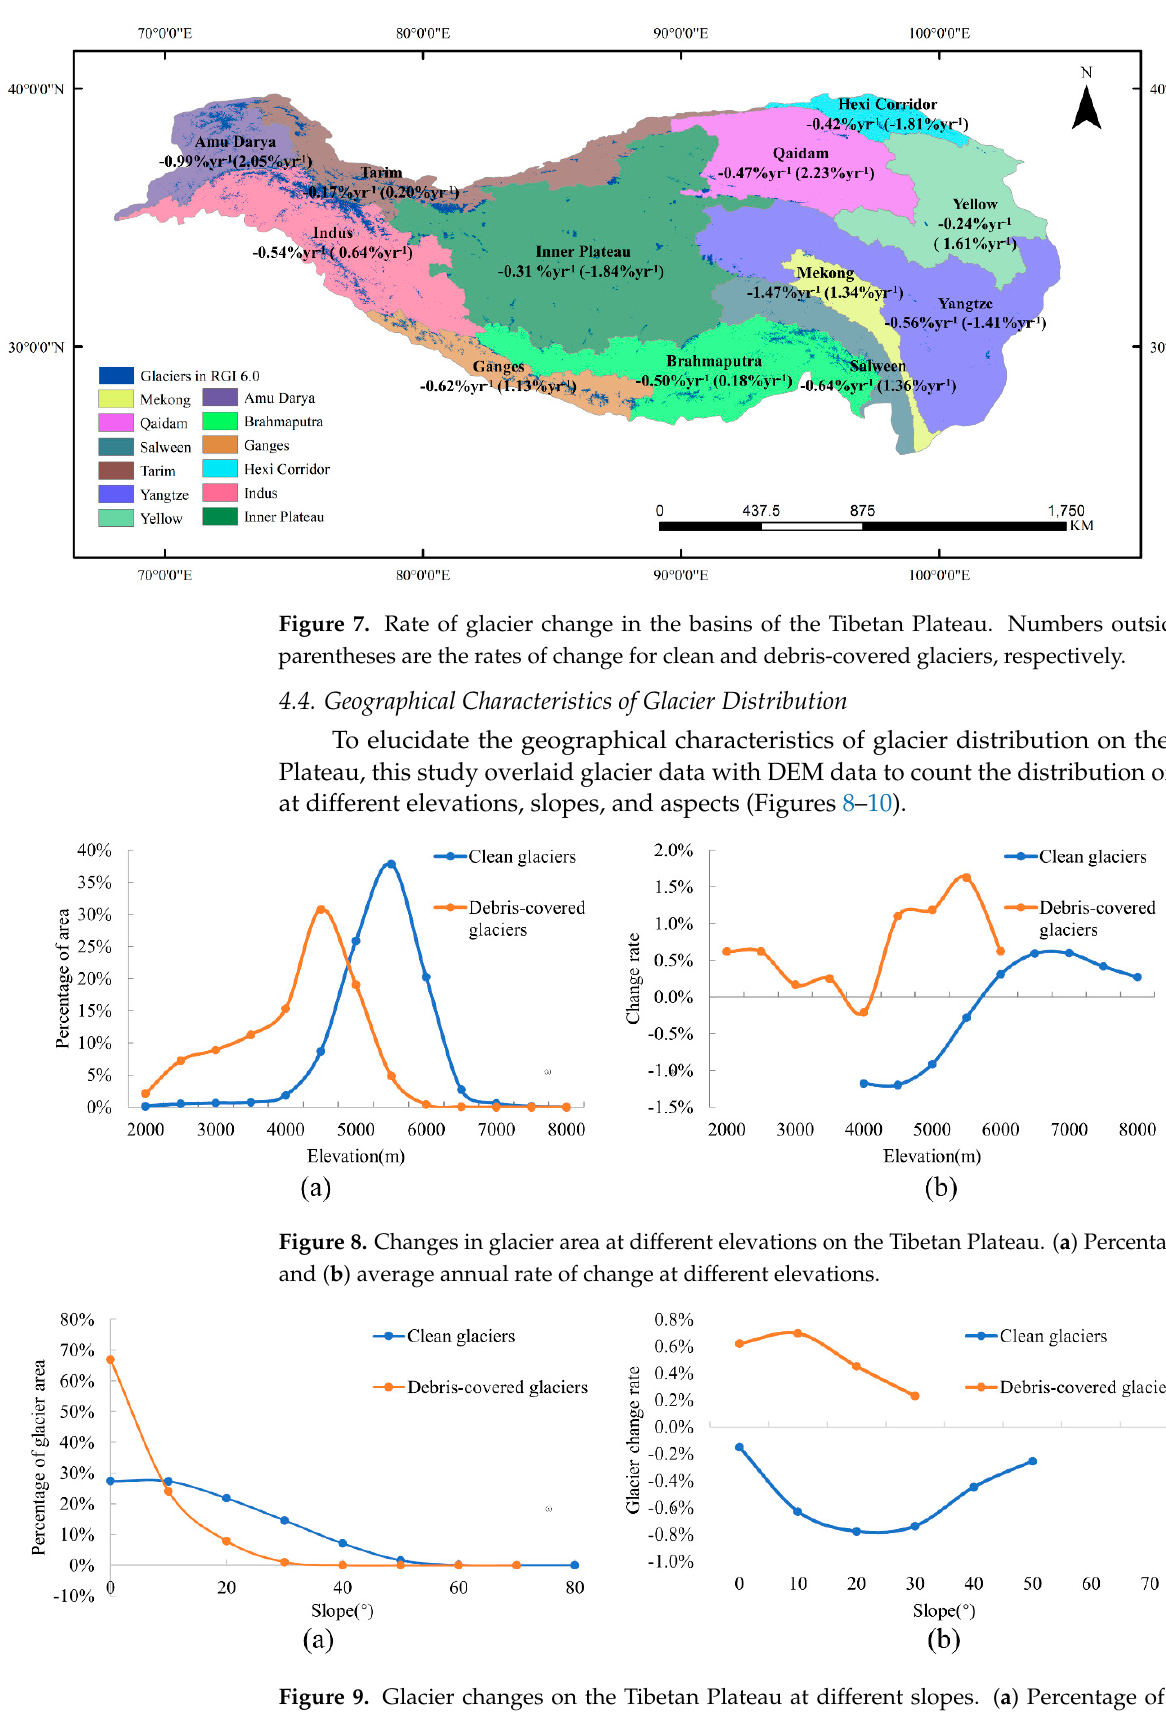
Figure 9. Glacier changes on the Tibetan Plateau at different slopes. ( a ) Percentage of area and ( b ) average annual rate of change at different elevations. 4.4.3. Glacier Distribution in Different Aspects The clean glaciers were less distributed in the south or southwest slope and more distributed in the northeast slope, and the glaciers in the northeast slope retreated fastest. The debris-covered glaciers were more distributed in the northeast and southwest slope, while the glaciers expanded faster in the southeast slope and slower in the northwest slope (Figure 10). It may be related to the plateau monsoon climate and water vapor source [56,57].